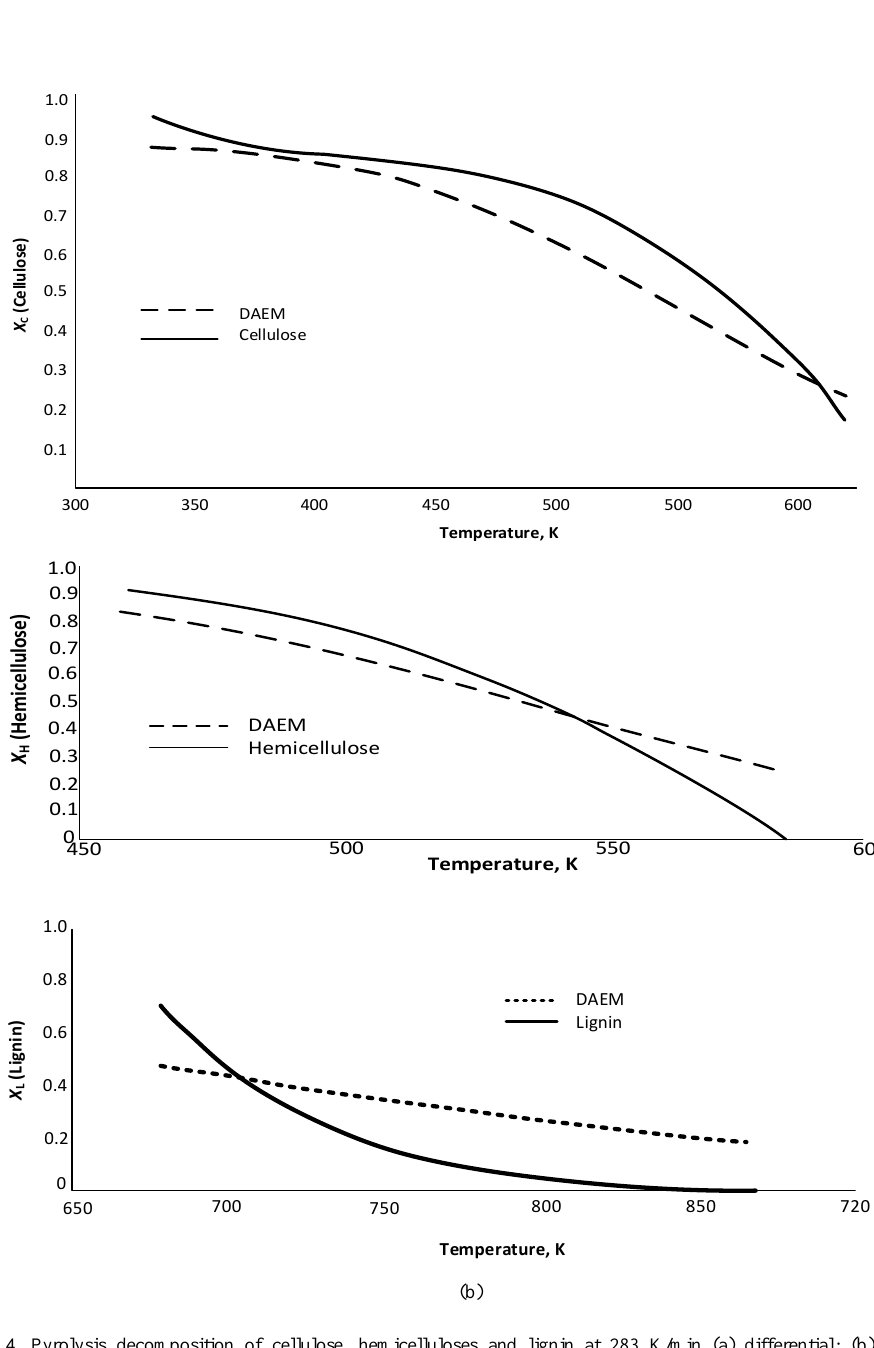
Fig.4. Pyrolysis decomposition of cellulose, hemicelluloses and lignin at 283 K/min (a) differential; (b) integral